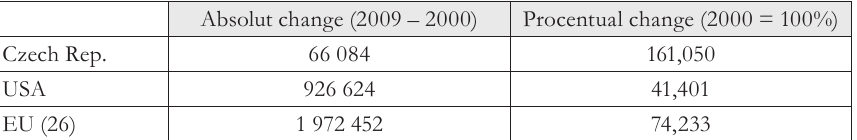
Tab. 2 - Changes in the number of tertiary education graduates in the period 2000-2009. Source: (Eurostat, 2013a), own processing.